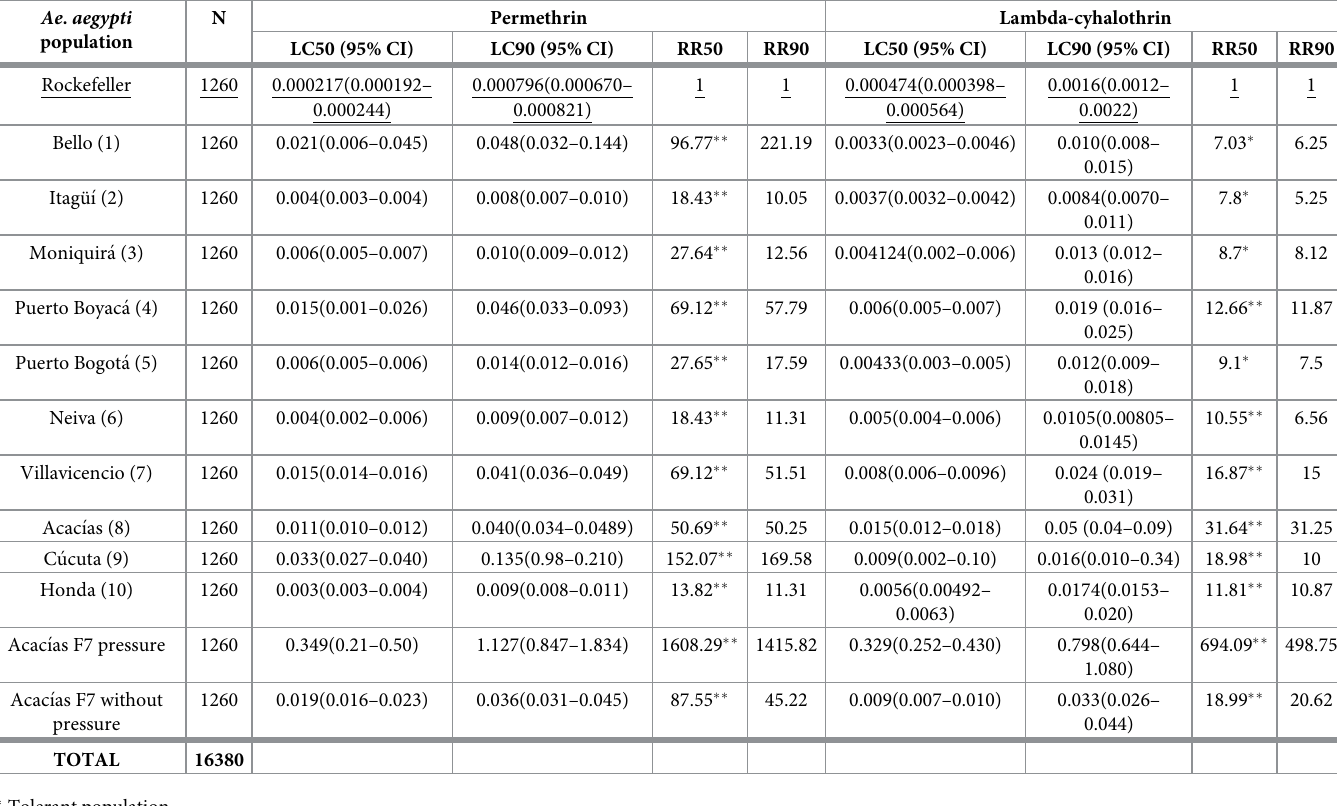
Table 1. Resistance ratio to Permethrin and Lambda-cyhalothrin of Aedes aegypti populations studied in